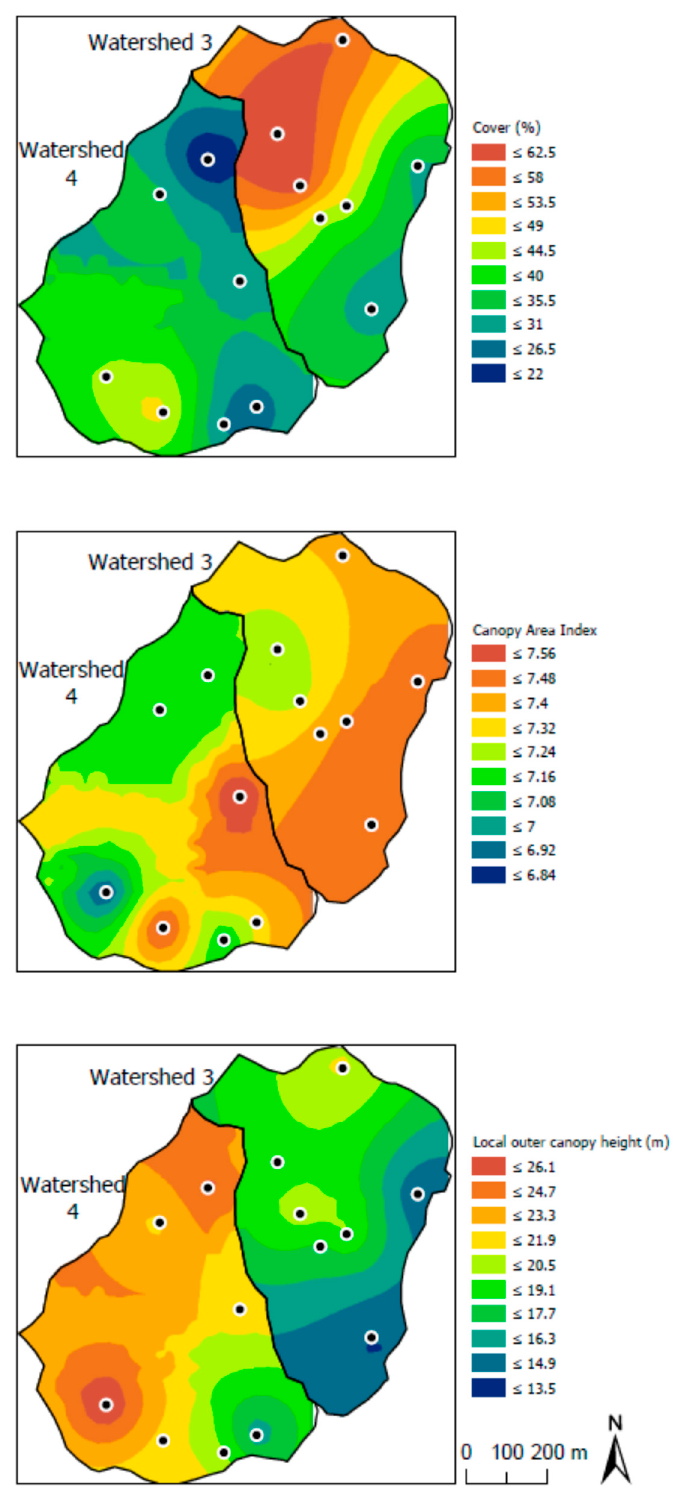
Figure 5. Spatial patterns of herbaceous layer cover, canopy area index, and local outer canopy height for study watersheds at Fernow Experimental Forest, West Virginia, July 2011. Shown also are locations of permanent sample plots on each watershed.